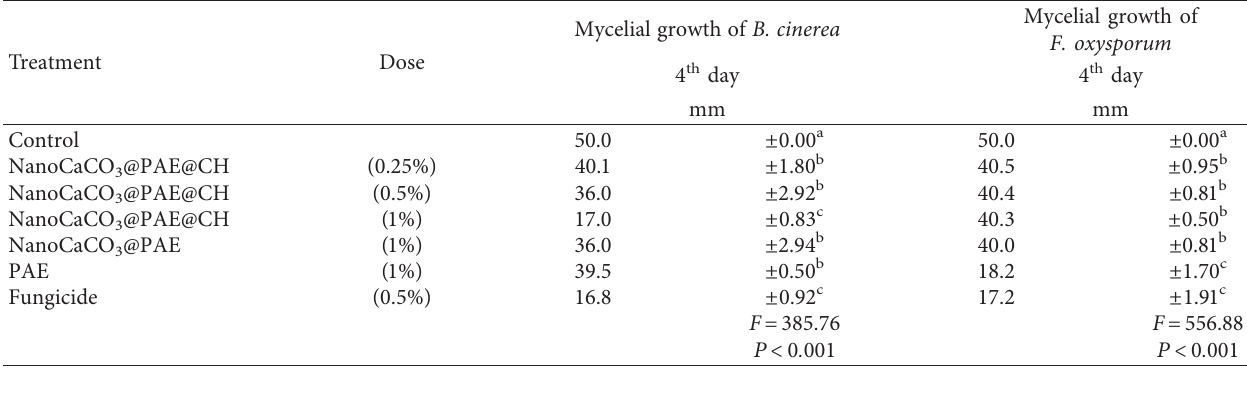
3 @PAE@CH. Values with different letters